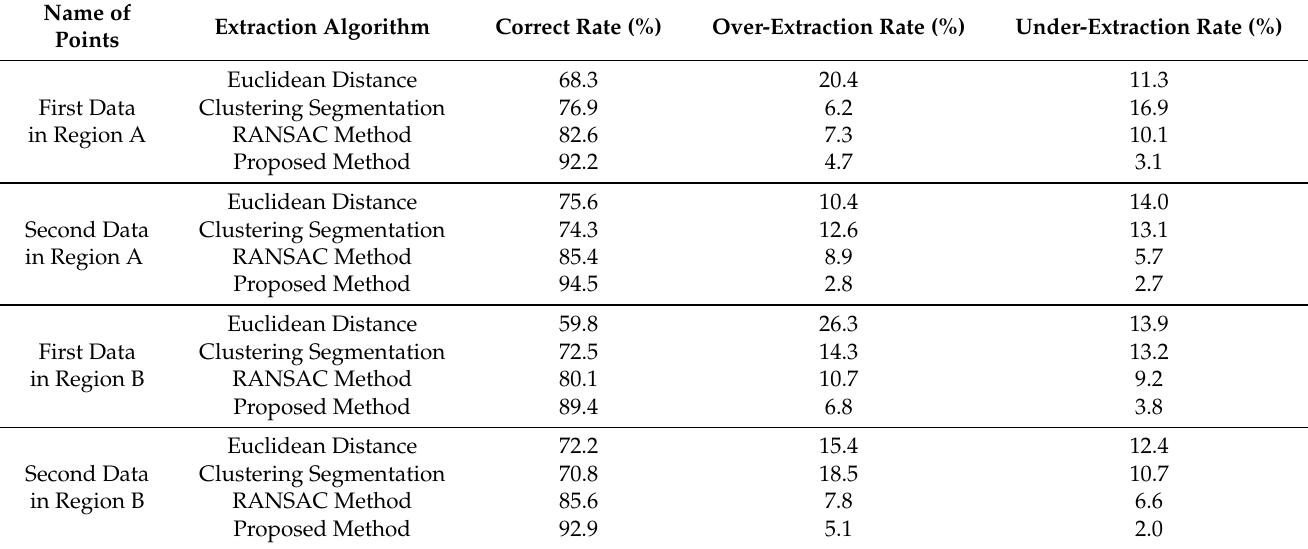
Table 1. Comparison of ski-track extraction effects with different extraction